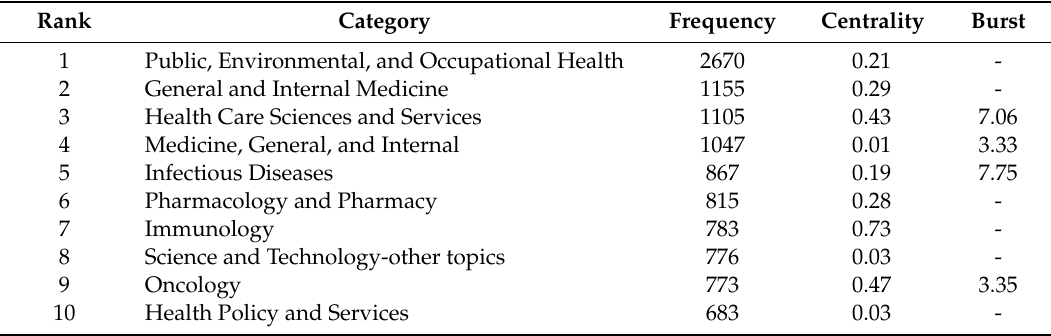
Figure 10. A comprehensive knowledge map in the global health research field: 1996–2019.